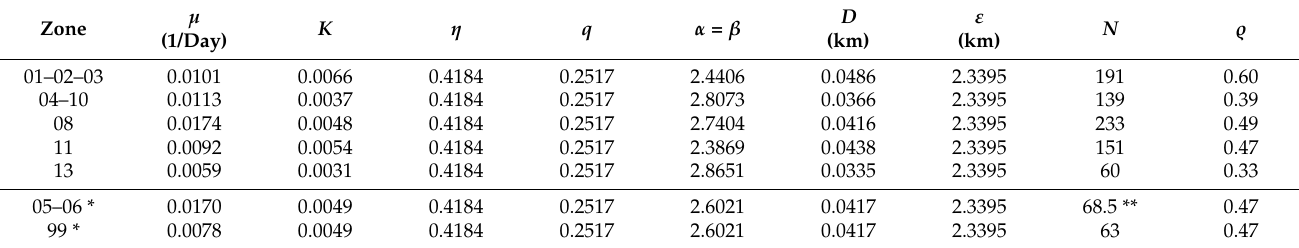
Table 4. Preferred ETAS parameters by zone after downscaling. The event numbers used for parame- ter downscaling and the implied branching ratios (cid:36) are also shown. The downscaling approaches were not applied to the Romanian border Zone 05–06 due to data deficiencies and to the residual Zone 99 due to boundary effects. Note that the µ background rates (without Zone 05–06) do not add up to the core area total µ 0 in Table 1; the difference is due to the non-covered residual activity in Zone 13.